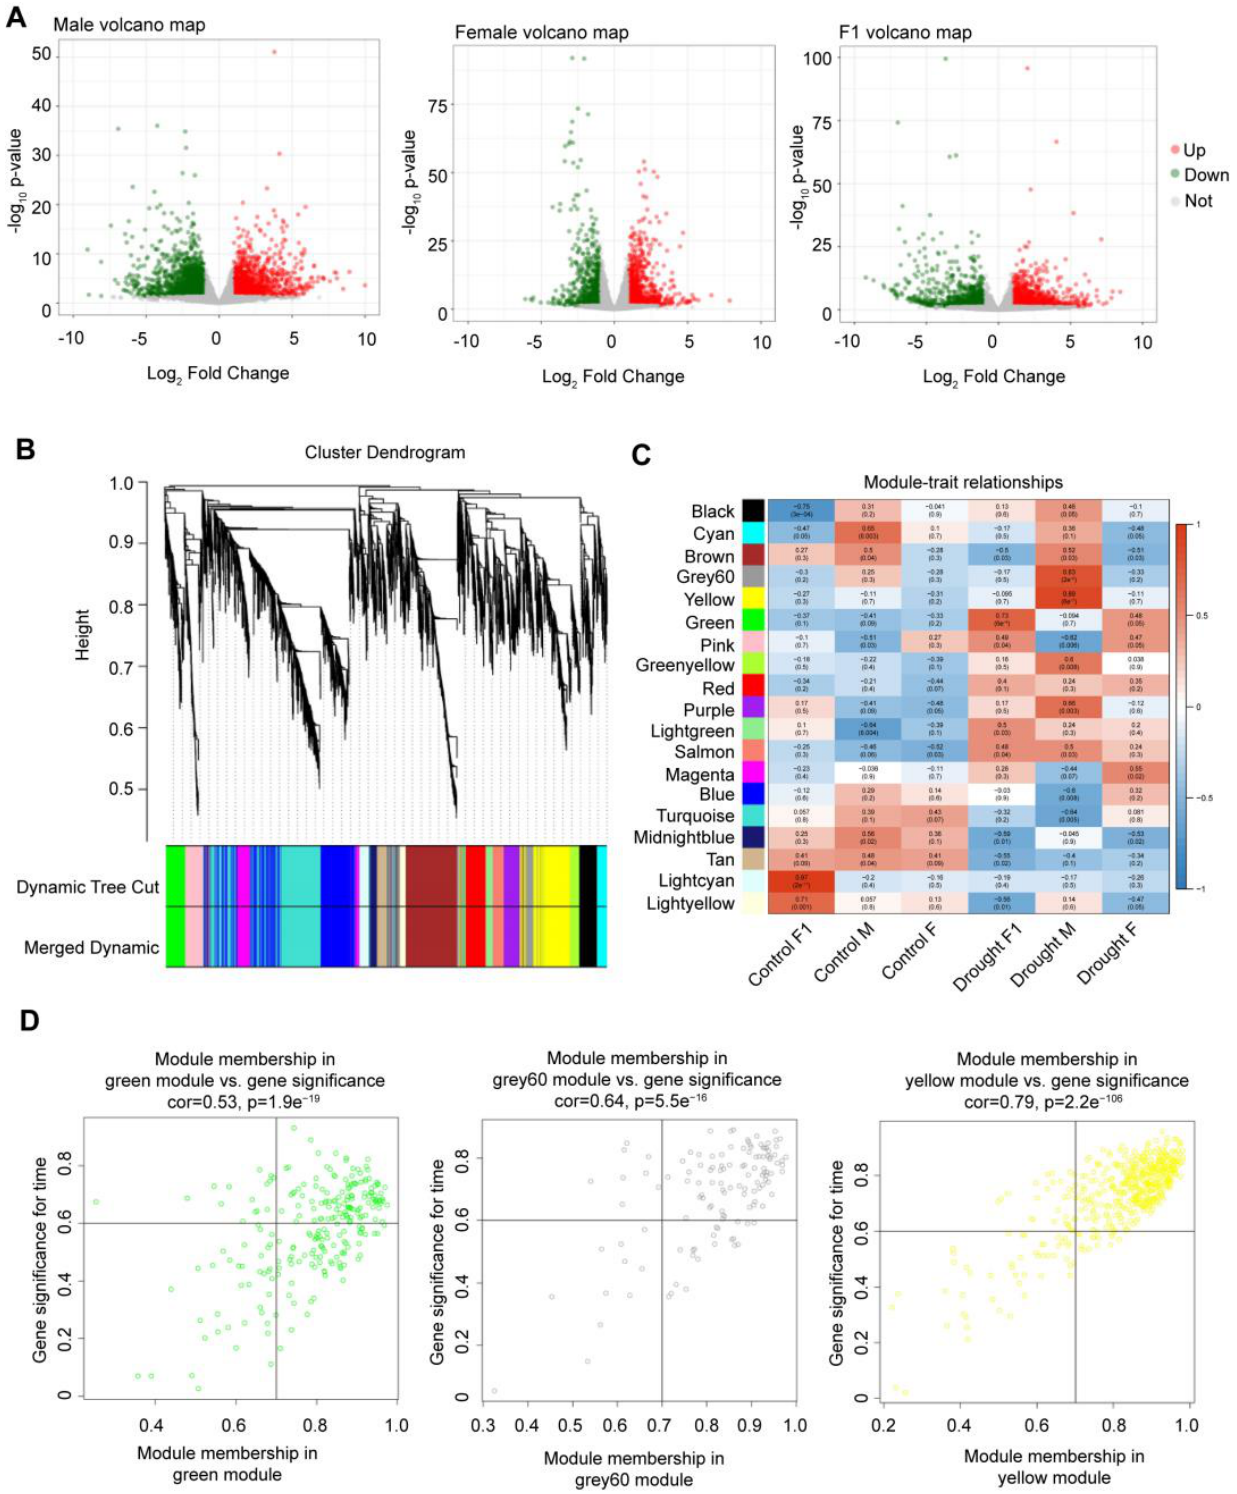
Figure 1. Screening of candidate genes for drought stress. ( A ) Volcano maps of F1, male, and female parents. Green and red represent downregulated genes and upregulated genes, respectively. ( B ) Hierarchical clustering diagram according to weighted gene co-expression network analysis modules. ( C ) Module–feature relationship. ( D ) Genes with high correlation coefficients in key modules (gene significance time > 0.6, module membership > 0.7).